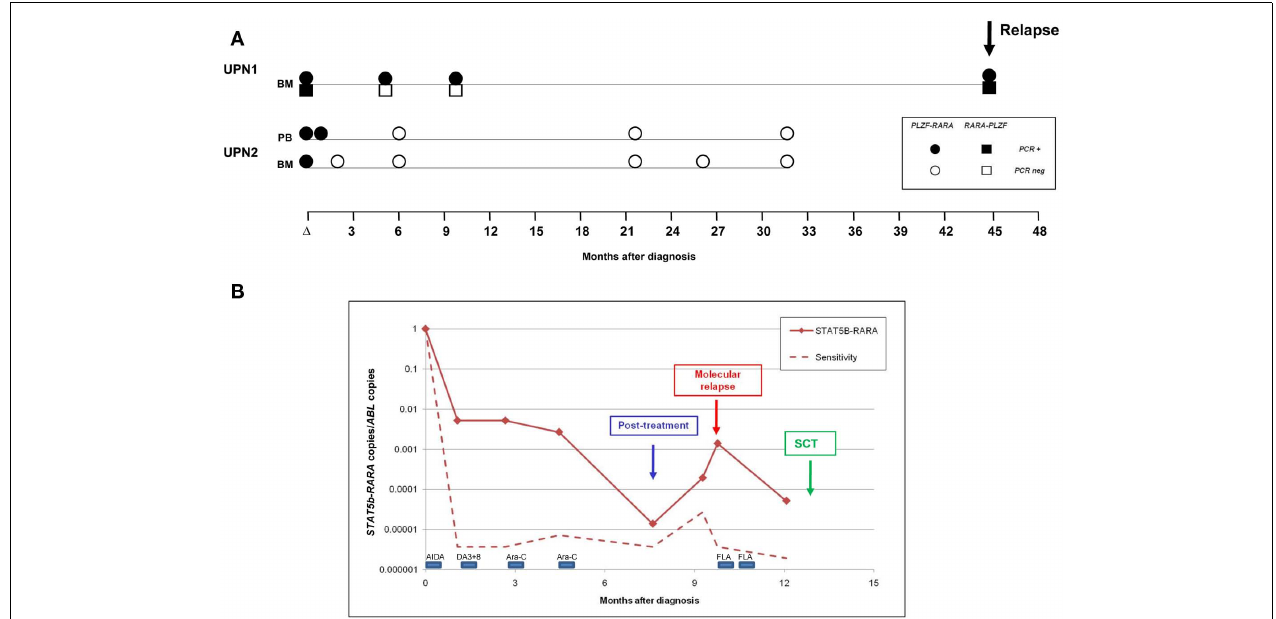
molecular remission following frontline therapy and remains in ongoing remission of their leukemia. (B) Serial monitoring of STAT5b–RARA transcripts normalized to the ABL control gene in UPN6.The patient failed to achieve molecular remission following frontline therapy and showed a rapidly rising fusion transcript level indicative of impending full blown relapse (labeled “molecular relapse”).The patient received two courses of Fludarabine and cytosine arabinoside (FLA) as pre-emptive therapy and then proceeded to a sibling myeloablative allogeneic stem cell transplant